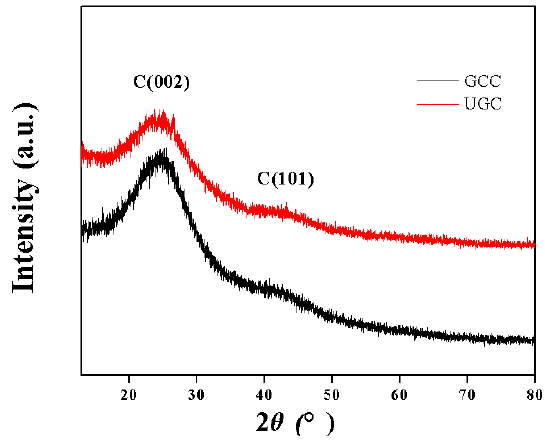
Figure 1. XRD patterns of unsulfonated glucose-derived carbon (UGC) and glucose-derived carbonaceous catalyst (GCC).